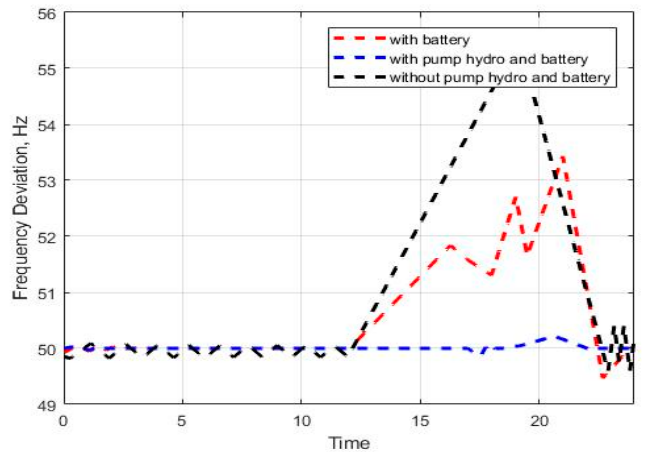
Figure 9. Frequency response of the microgrid with a sudden variation of load change.